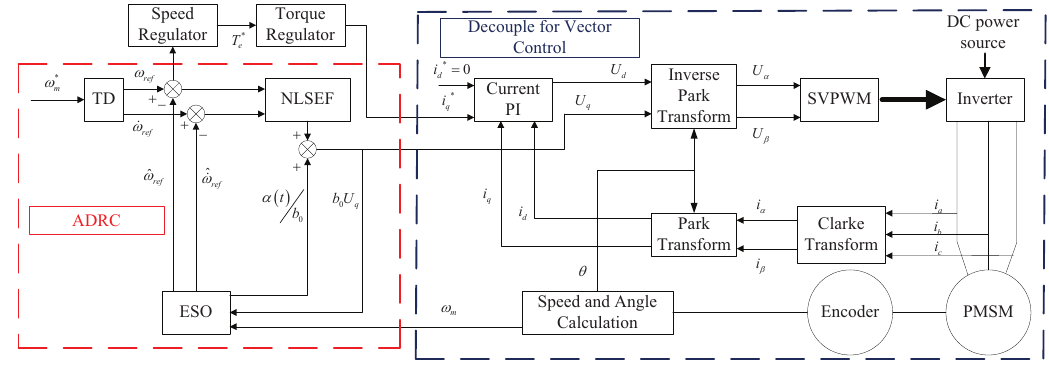
Figure 2. Control block diagram of PMSM speed control system based on